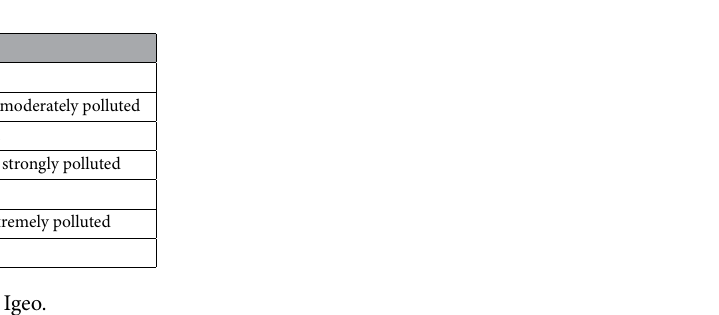
Table 1. Classification with